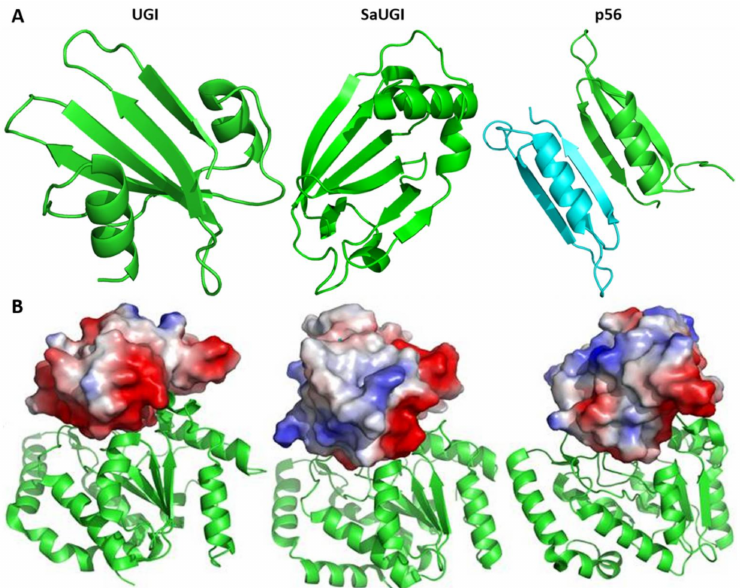
Figure 4. A structural comparison of UGI, SAUGI and p56 and their complexes with UNG. ( A ) Three- dimensional structures of the three known uracil-DNA glycosylase inhibitors, depicted as ribbon models (in green). The two monomers of p56 are shown in different colors (green and cyane). ( B ) Electrostatic representation of three inhibitor proteins (surface models colored according to electrostatics - red symbolizes negative charge, blue positive and white is neutral) in their complexes with UNG (ribbon model). It is clearly visible that in all three cases, the inhibitor protein binds to the UNG DNA-binding groove, mimicking the negative charge of the DNA. The figures were produced using the PyMOL program based on structural data from PDB database (PDB ID: UGI: 1UGI; SaUGI: 3WDG; p56: 2LE2; E. coli UNG complex with UGI: 1LQM; S. aureus UNG complex with SaUGI: 3WDG; B. subtilis UNG complex with p56 dimer: 3ZOQ)